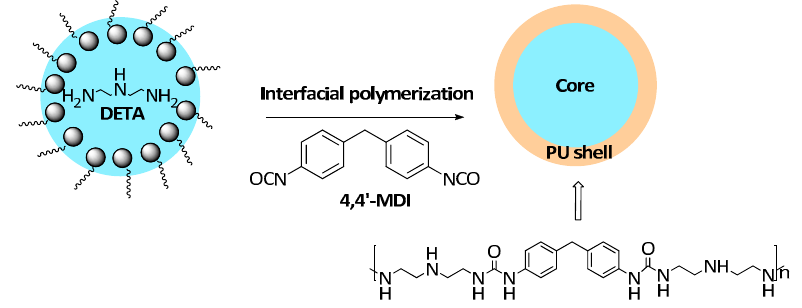
Figure 1. Preparation of polyurea nano-capsules from water-in-oil (W / O) nano-emulsion.